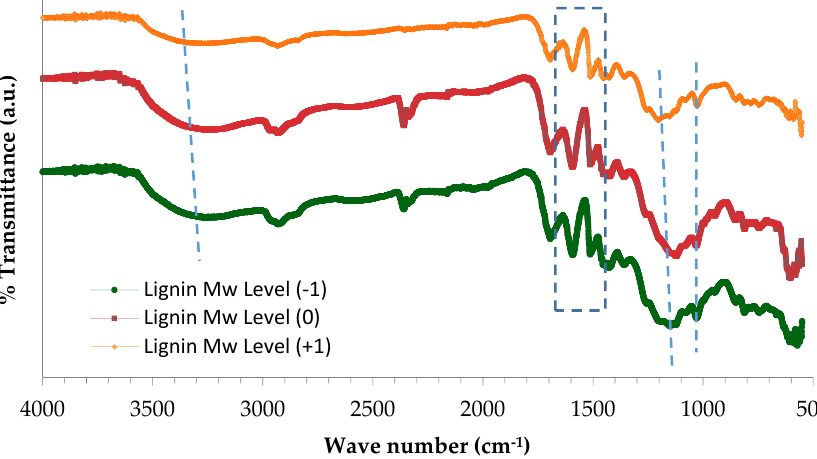
Figure 1. Fourier Transform Infrared (FT-IR) Spectra of DKL products of three levels of M w ( − 1), (0), (+1).